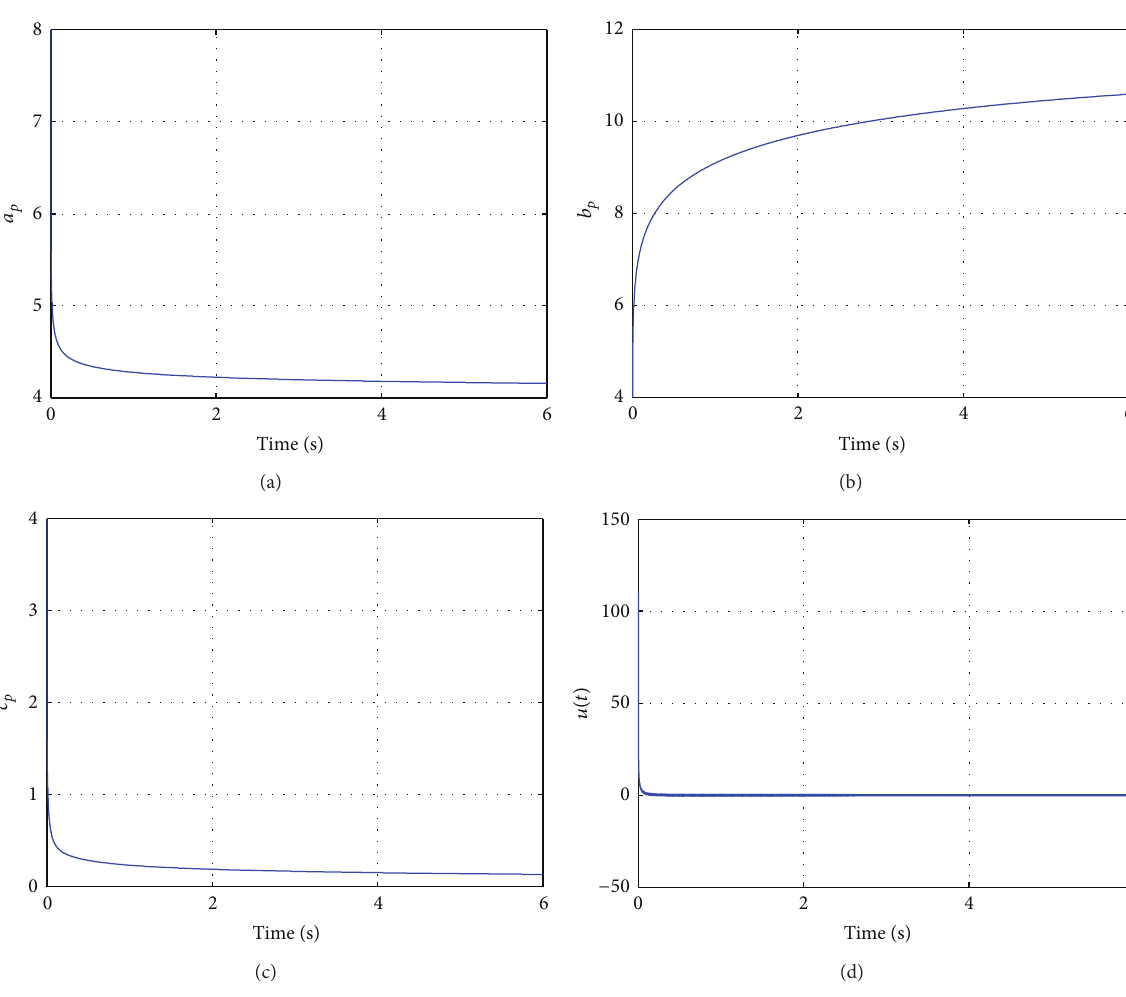
Figure 3: Fractional adaptive control of the fractional nonlinear system (26). (a) Estimation of parameter 𝑎 𝑝 (𝑡) ; (b) parameter 𝑏 𝑝 (𝑡) ; (c) estimation of parameter 𝑐 𝑝 (𝑡) ; (d) control input 𝑢(𝑡)